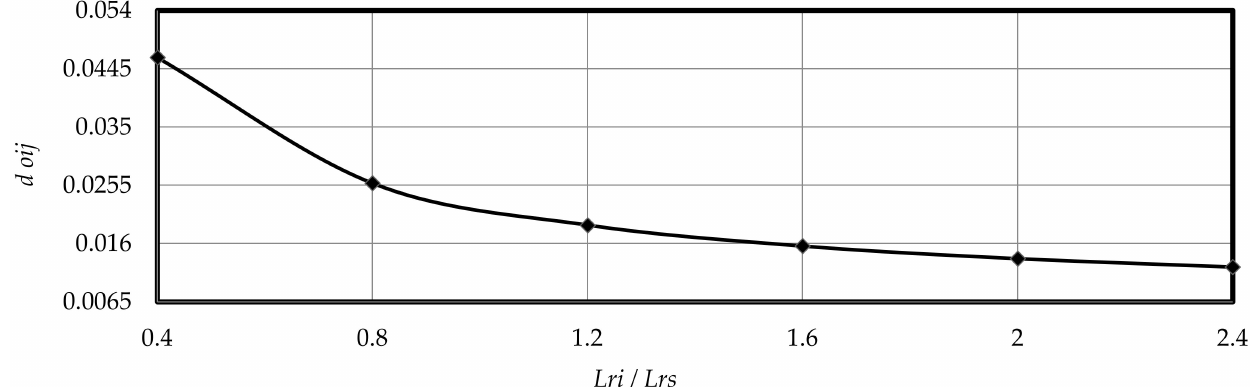
Figure 6. Graph of the change in trip distribution function of urban employers of service enterprises depending on the relation of the distance of the zone of departure to the city center to the average distance of zones of the city from the center.